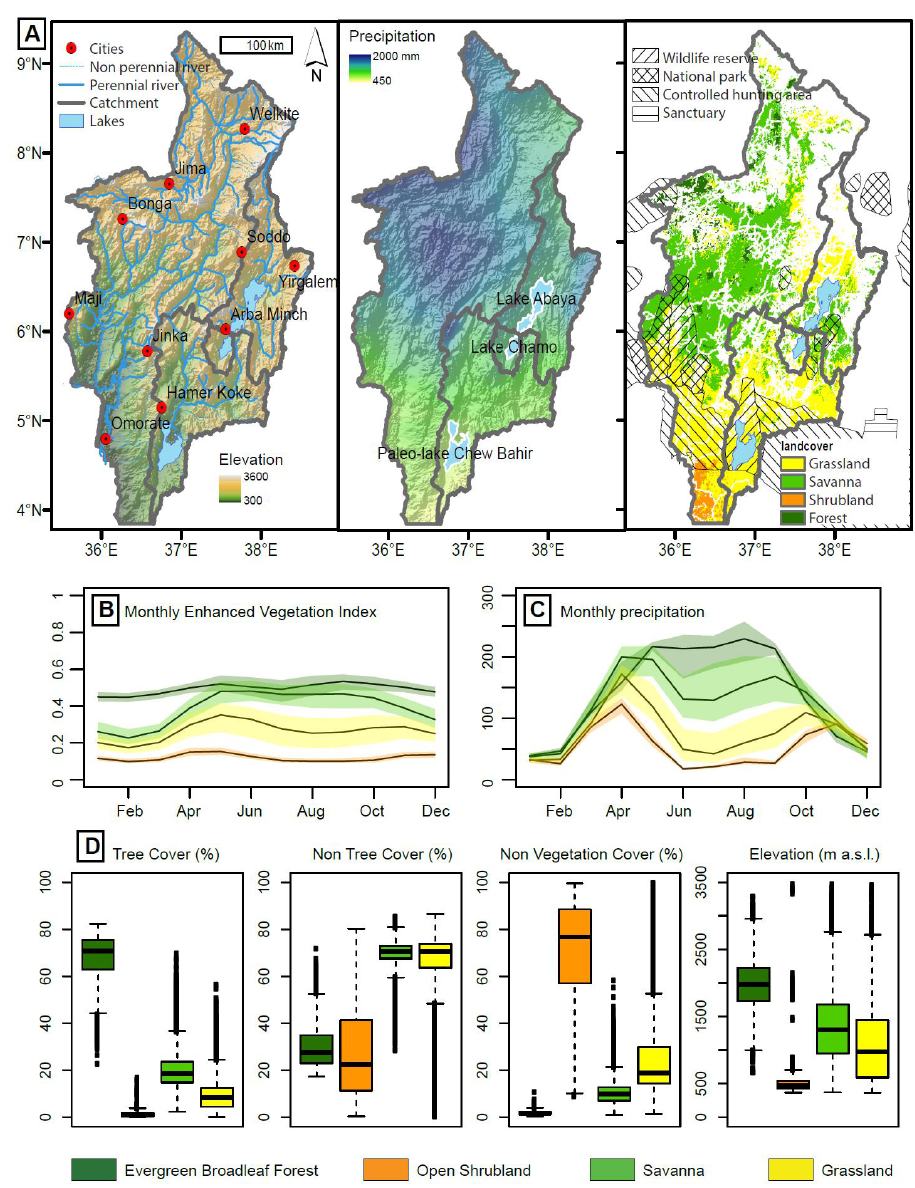
Figure 3. Dataset exploration used for training and prediction: ( A ) Maps of the datasets used in this study with SRTM based elevation, annual precipitation and LC with protected areas. Plots of the datasets used in this study with ( B ) monthly EVI interquartile range for each landcover class, ( C ) monthly GPM precipitation (mm) interquartile range for each class and ( D ) boxplots of the TC, NTC, NVC and elevation for each